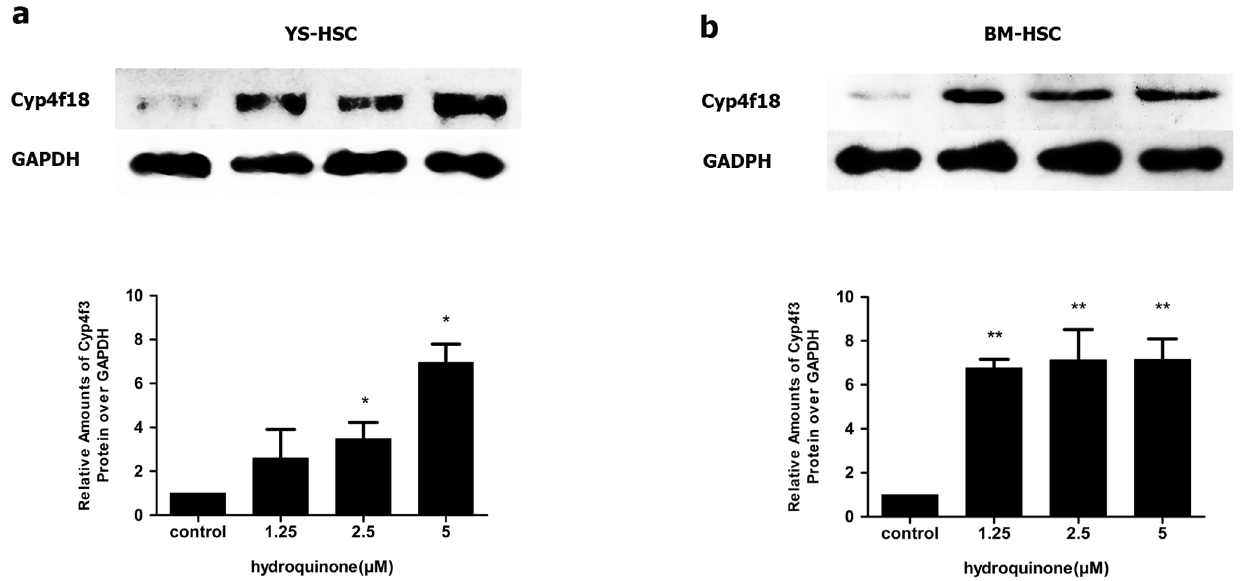
Figure 8. Effects of HQ on Cyp4F18 protein expression. Immunoblot analysis of Cyp4f18 proteins on HQ-treated YS-HSC (a) and BM-HSC (b) cells. Immunoblotting of Cyp4F18 was shown in the upper panels. GAPDH was measured as loading control. Densitometry of immunoblot results was shown in the lower panels. Values are presented as means 6 SDs (n=3–5). *, P , 0.05; ** P , 0.01; compared with controls.